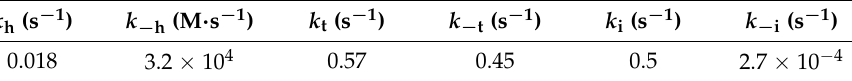
Table 3. Rate constants for compound 1 .